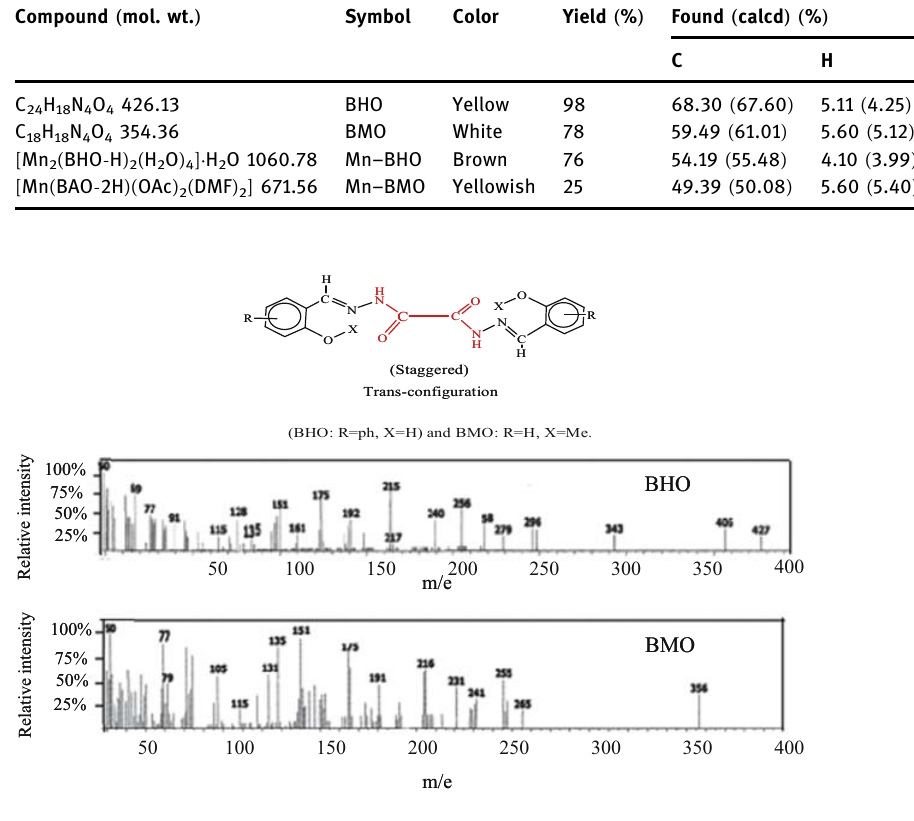
Figure 1: Mass spectra of the ligands ( BHO and BMO ) .